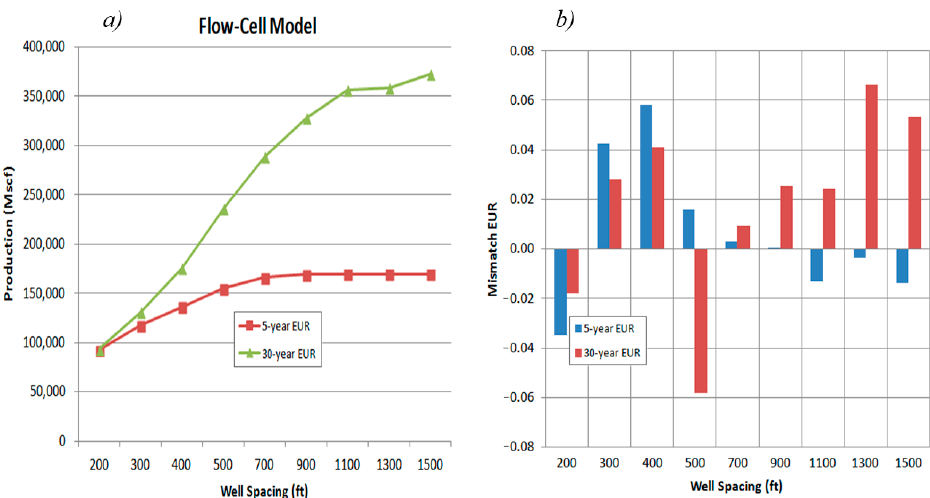
Figure 14. Flow-cell model-based production performance forecasts for Utica wells with well spacing ranging between 200 and 1500 ft. The base case performance is for the Utica type well with 55 ft fracture spacing. The impact of wider and narrower well spacing on well productivity is graphed for both ( a ) the cumulative, and ( b ) daily production rates.